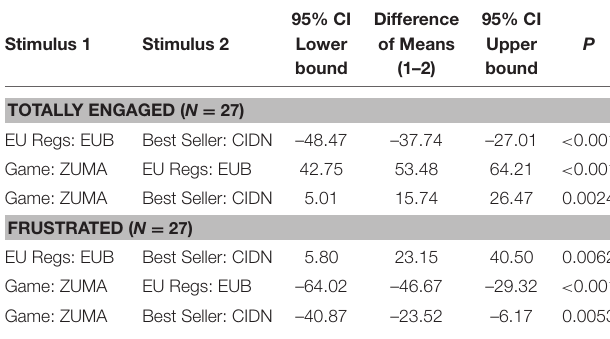
TABLE 9 | Comparison of subjective responses elicited by each interactive